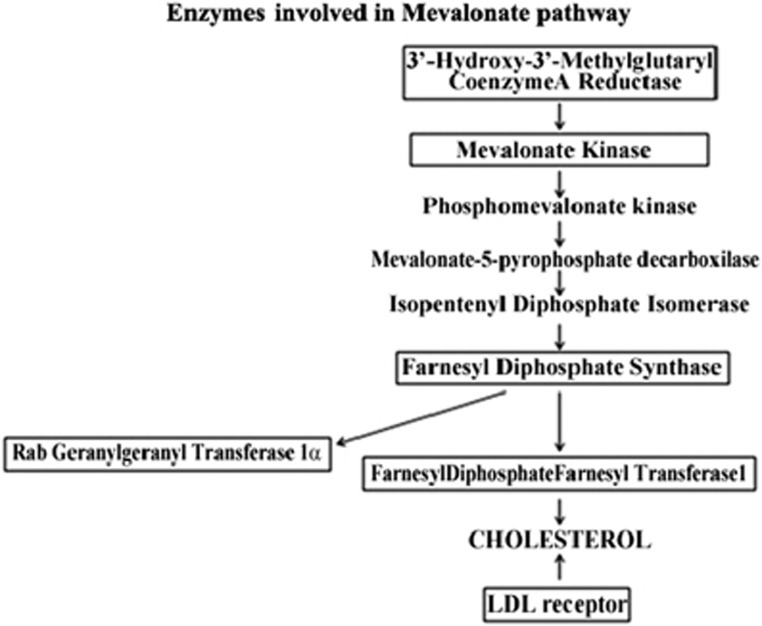
Scheme 1Enzymes involved in MVA pathway